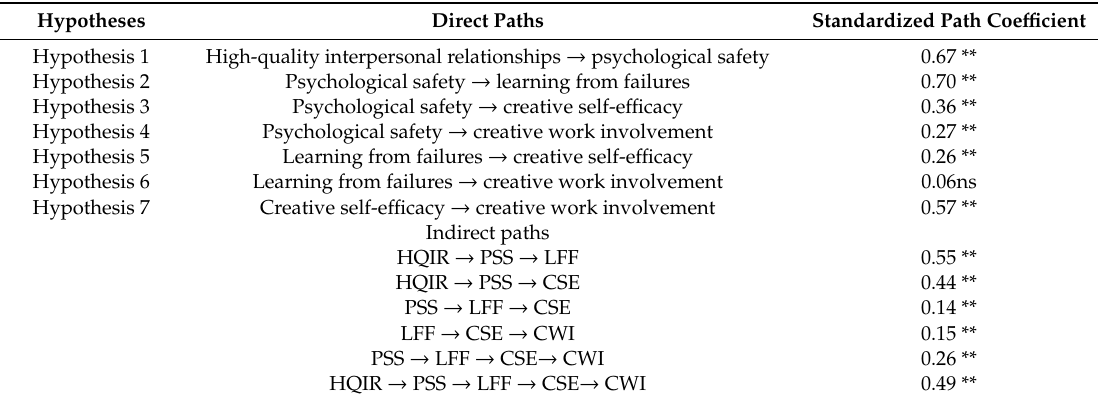
Table 5. A summary of the results that were used to test the research hypotheses.